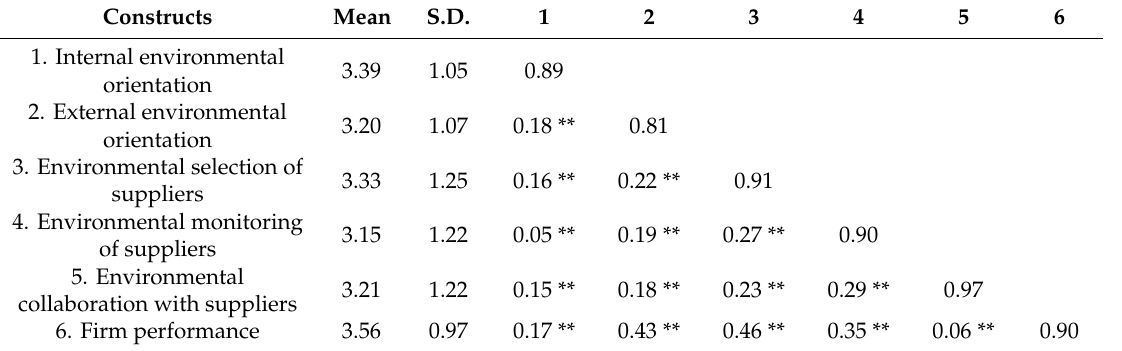
Table 3. Means, standard deviations, and Pearson correlations.